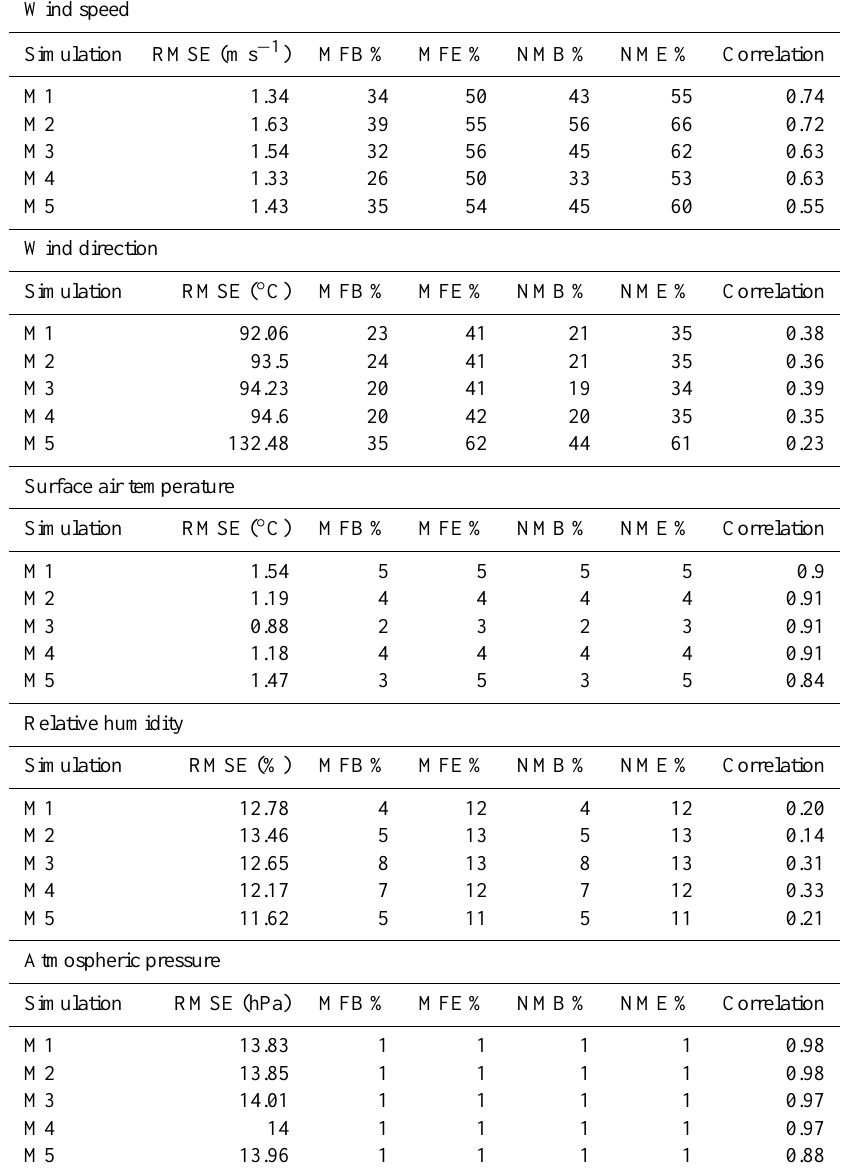
Table 2. Statistical performance evaluation of the meteorological variables for the WRF simulations. Wind